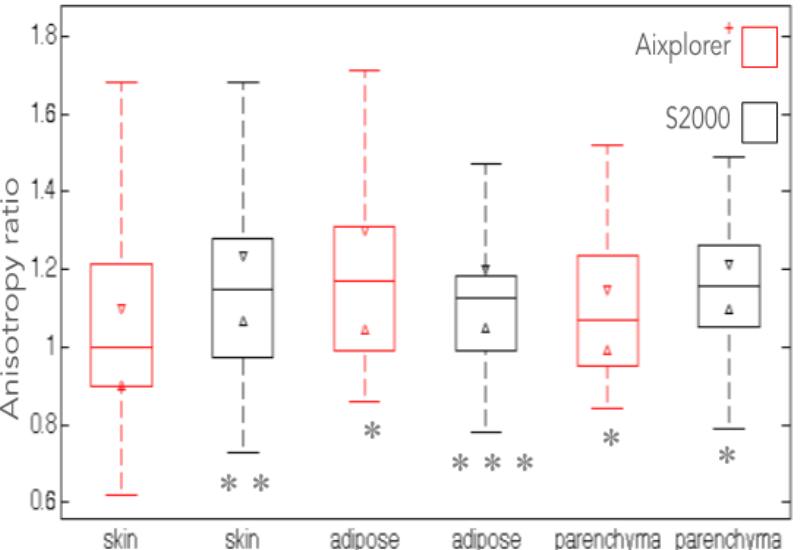
Figure 6. Anisotropy ratios (ratio of mean anti-radial c s to mean radial c s in individual pairs of elastograms obtained at the same location in the same breast quadrant on the same breast in the same individual) measured in skin, adipose and parenchyma for Aixplorer and S2000. *, ** or *** indicates where median c s estimates for anti-radial and radial transducer orientations were significantly different with p -value < 0.05, < 0.01 or < 0.001, respectively.